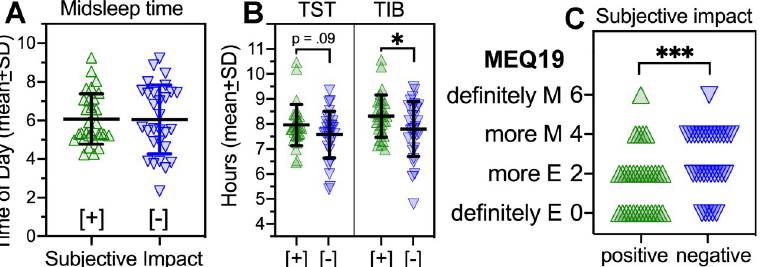
Fig 10. Midsleep time, sleep duration and morning-evening preference in relation to an inferred net positive (+) or negative (-) response to sleep changes during the social-distancing semester in the 2020 group. [ A]. Midsleep time, across all days. [B]. Left panel: Total daily sleep duration, across all days. Right panel: Nocturnal time in bed (TIB). Independent samples t-tests, � p < .05 [C]. Self-identified evening-preference, from question 19 on the Morning- Evening Questionnaire (MEQ). Mann-Whitney U test, ��� p < .001. Green triangles denote positive responders (N = 31). Purple inverted triangles denote negative responders (N =